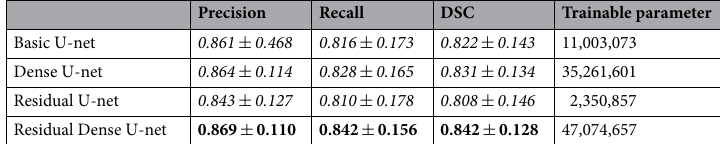
Table 2. Evaluation metrics for four pancreas segmentation models. Results are indicated as mean ± standard deviation, and the best performances are indicated in bold. The results are highlighted in italics if the residual dense u-net performs significantly better than the corresponding method. We used a significance level of 0.05 and a paired t test for network comparison. DSC, dice similarity coefficient.